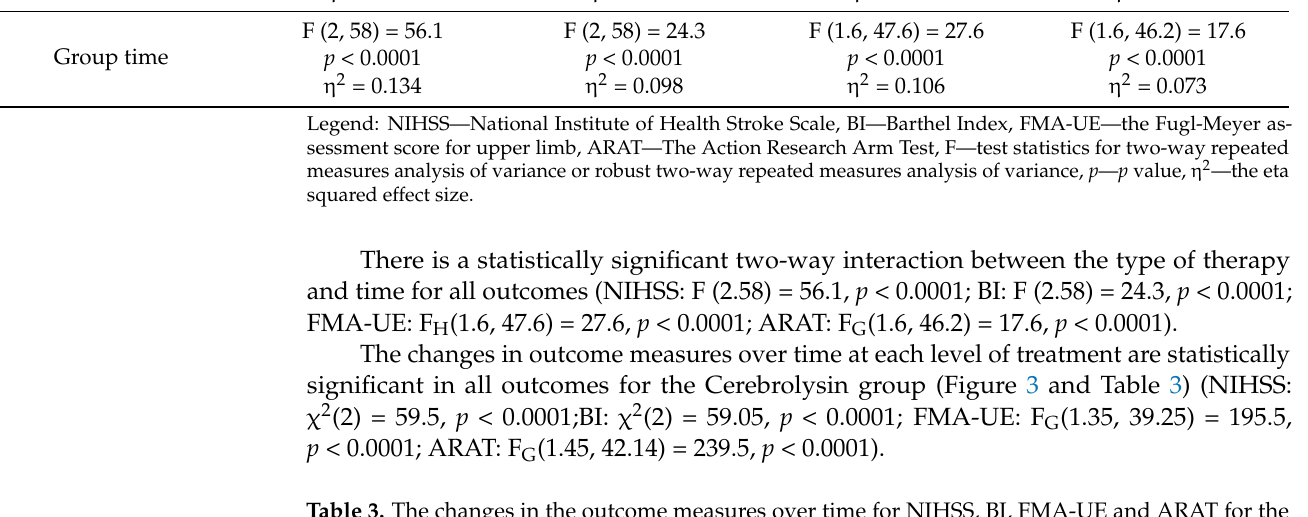
Table 3. The changes in the outcome measures over time for NIHSS, BI, FMA-UE and ARAT for the Cerebrolysin